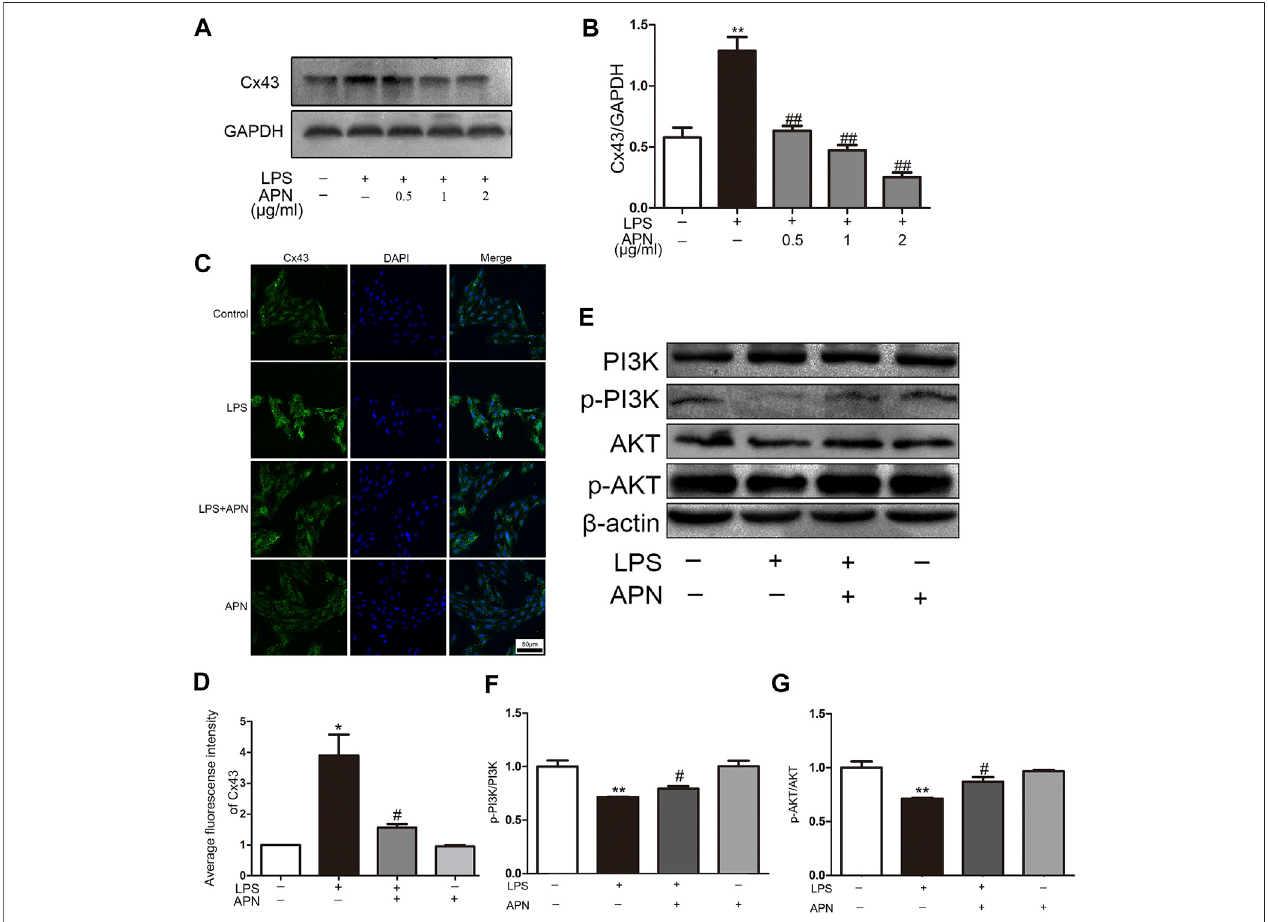
FIGURE 2 | APN downregulates Cx43 expression and activates the PI3K/AKT signaling pathway. (A) The effects of LPS and APN on Cx43. (B) Statistical analysis of Cx43. (C) Fluorescence intensity of Cx43 after treatment with LPS and APN. Scale bar: 50 μ m (D) Quantitative analysis of the relative fl uorescence intensity of Cx43. (E) The effects of LPS and APN on PI3K, p-PI3K, AKT, and p-AKTproteins. (F – G) Quanti fi cation of p-PI3K/PI3K and p-AKT/AKT levels (* P < 0.05, ** P < 0.01 vs. control; # p < 0.05, ## p < 0.01 vs. the LPS group. The data are shown as the means ± SEs (n (cid:2)